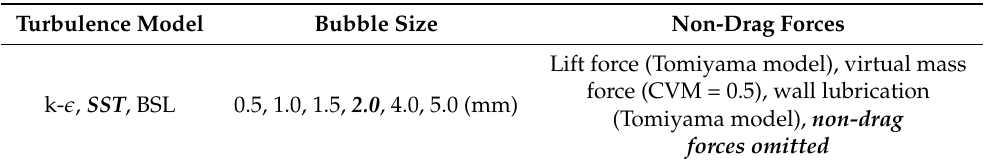
Table 1. Configuration parameters for CFD code definition. The final parameters are identified in bold font. SST: shear stress transport, BSL: baseline.